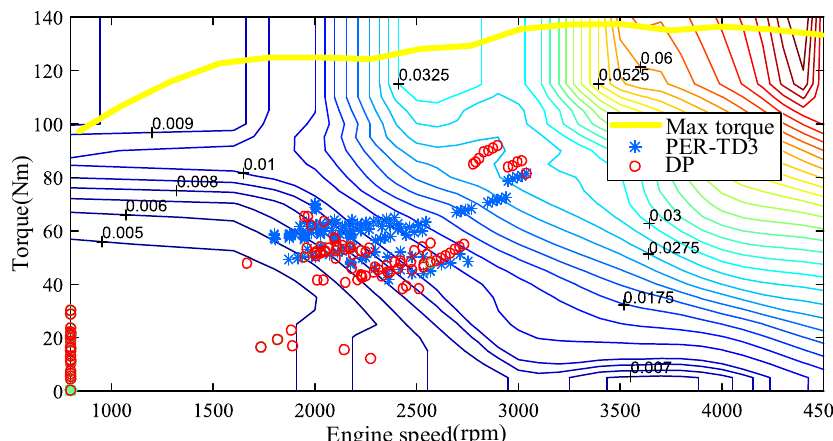
Figure 16 . Distribution of the engine workload on the NO x emissions map. Figure 16. Distribution of the engine workload on the NO x emissions map.